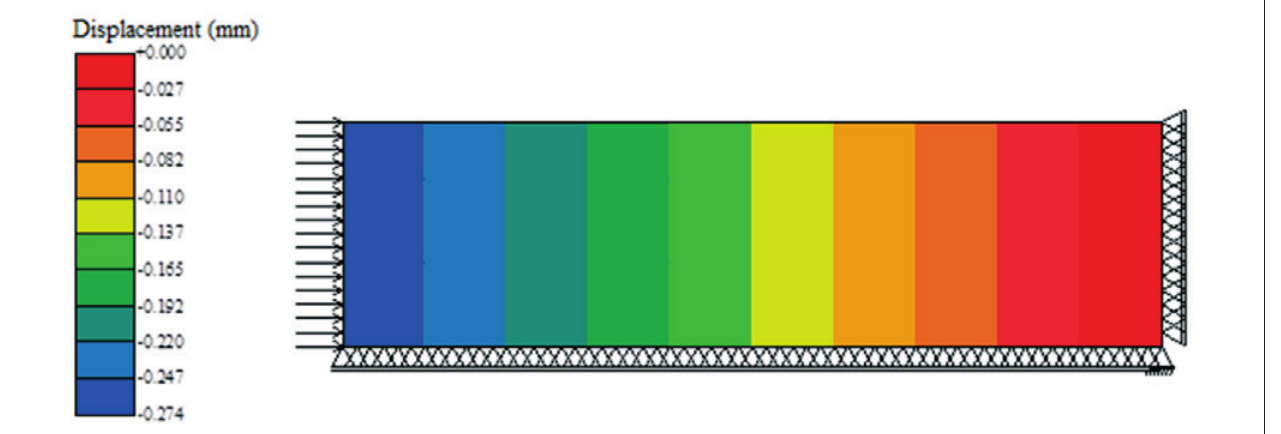
Figure 9 – Displacement on "x" direction due to AAR at 8000 days of age of concrete for the case